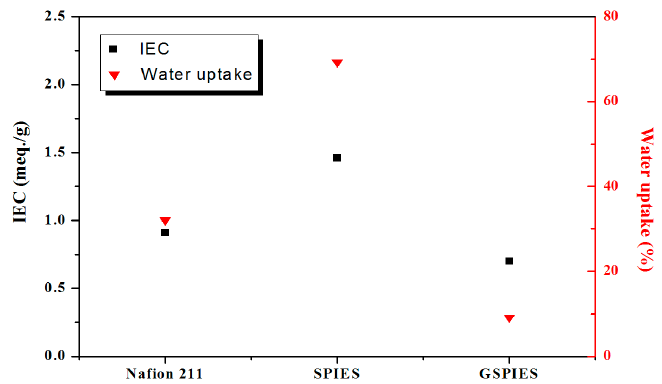
Figure 6. Ion exchange capacity (IEC) and water uptake of SPIES and GSPIES compared with Nafion 211 ® .